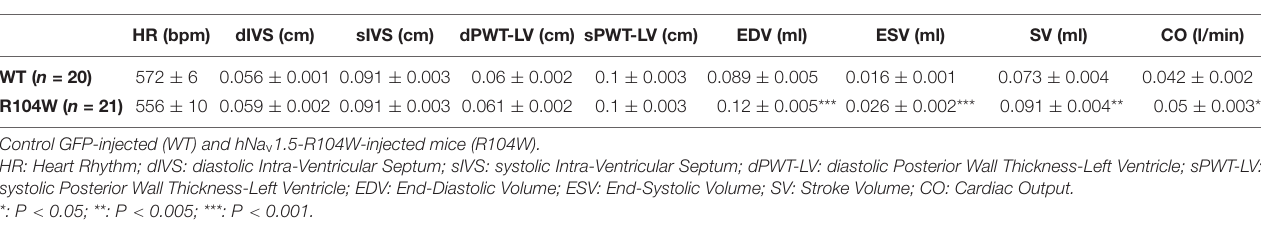
FIGURE 3 | Cardiac functional effects of the dominant-negative mutant R104W in Na v 1.5. (A) Left ventricular diameter (in cm), left ventricular ejection fraction and fractional shortening (in %) measured by echocardiography in GFP-injected ( n = 20) and Na v 1.5-R104W-injected mice ( n = 21). Overexpression of the hNa v 1.5-R104W channel induced a significant left ventricular dilation combined to a significant reduction of left ventricular ejection fraction and fractional shortening. (B) RR interval, PR interval, and P wave duration (in ms) measured on ECG recordings in control ( n = 27) and hNa v 1.5-R104W-injected mice ( n = 24). Overexpression of the hNa v 1.5-R104W mutant channel led to a slight but significant prolongation of RR interval and P wave duration. PR interval was also slightly increased in R104W overexpressing mice when compared to controls, but not significantly. *: P < 0.05; **: P < 0.005; ***: P < 0.001; ****: P < 0.0001. TABLE 2 | Echocardiographic